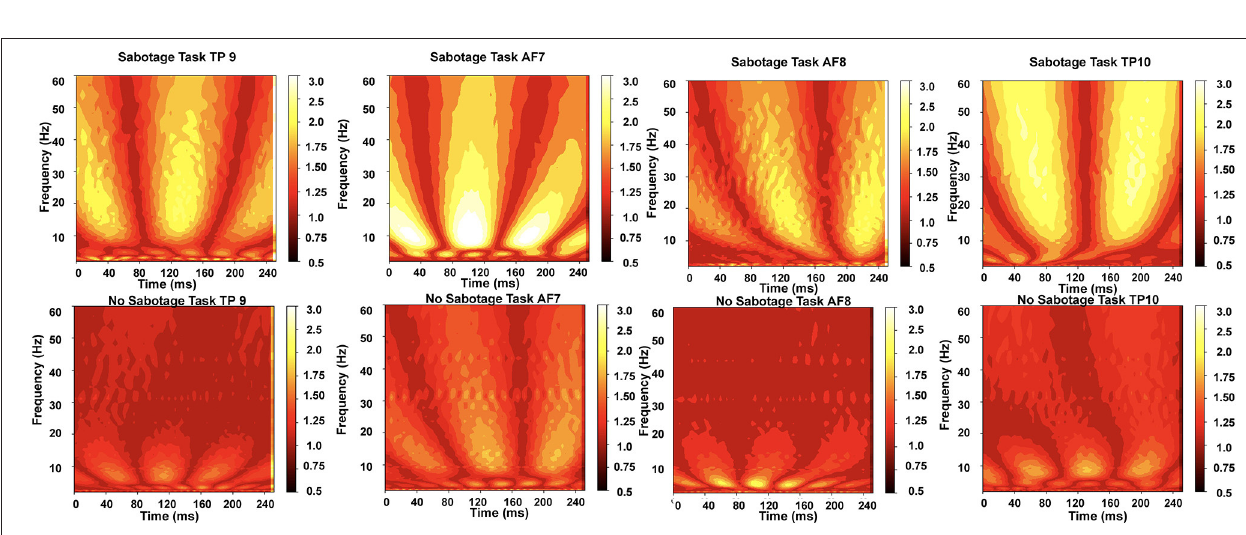
FIGURE 4 | The normalized scalograms obtained for the two tasks from the four channels; we can observe that higher frequencies (alpha to beta measured in Hz) are more active for sabotage task than for no-sabotage task.